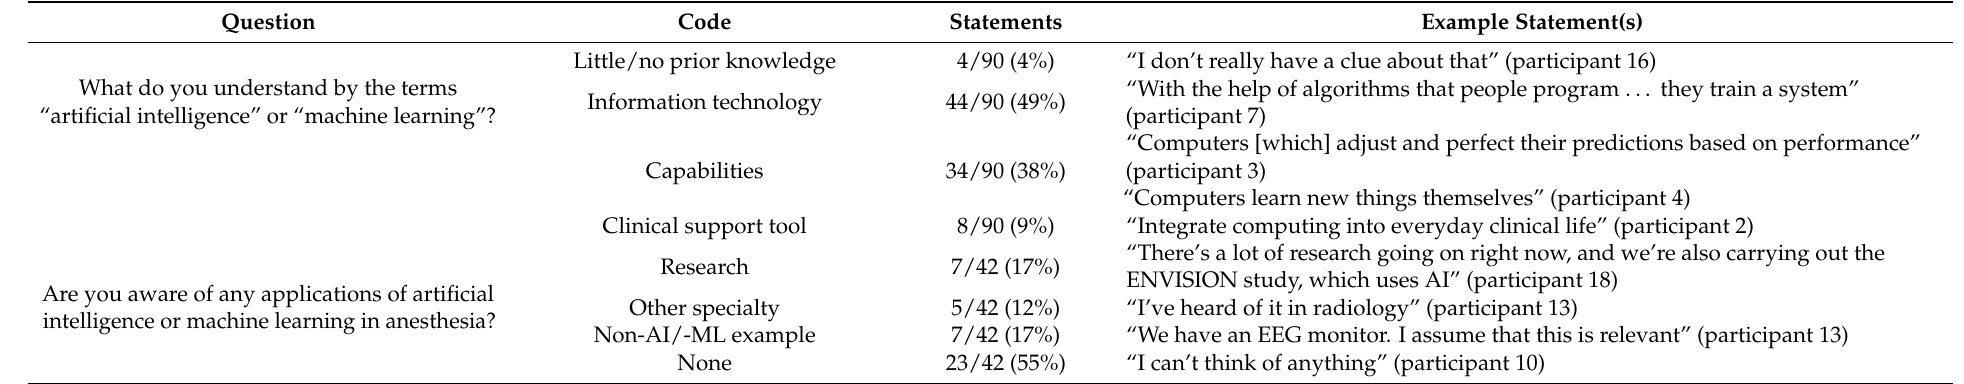
Table 2. An overview of responses to questions 1 and 2, demonstrating a good pre-existing understanding of AI, with example statements. Values are number (percentage).